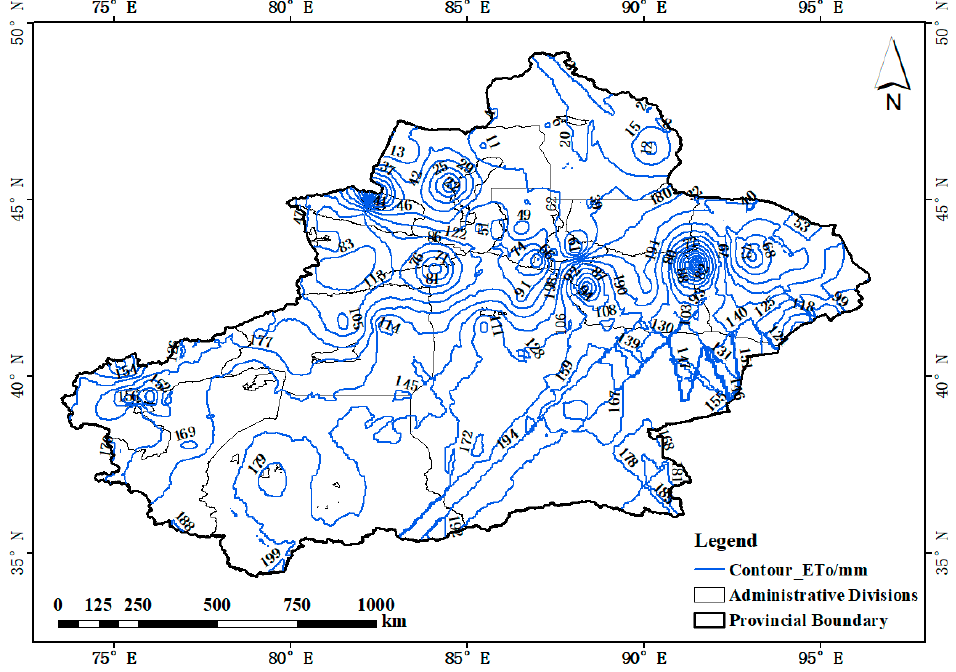
Figure 8. Spatial distribution of the potential evapotranspiration in Xinjiang.